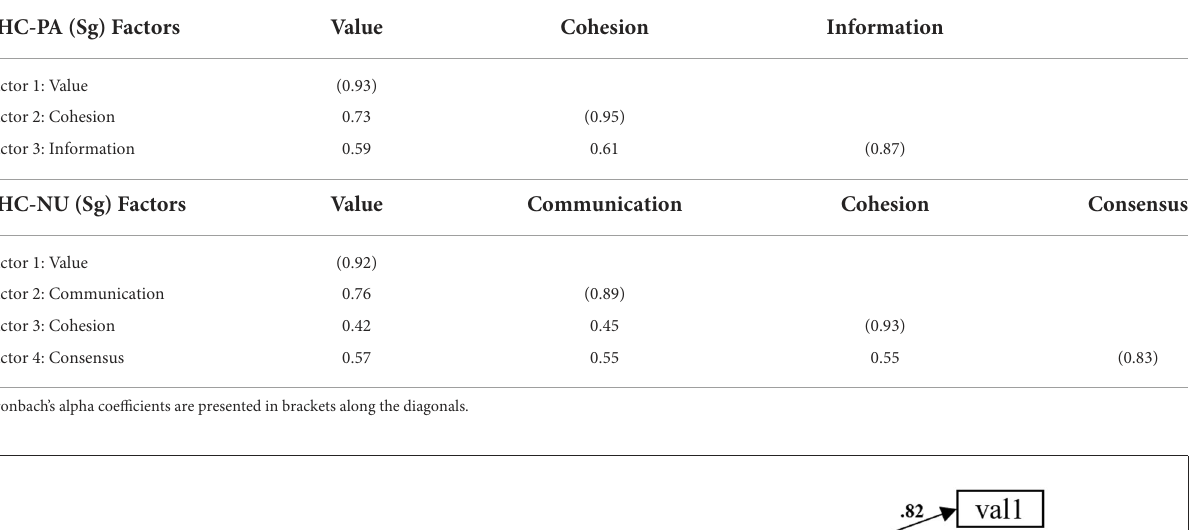
factors were smaller than their reliability coefficients (Table 3), indicating unique variance measured by the factors (42), their internal consistency was high (0.93 and 0.83 for cohesion and consensus respectively; Table 3), and their inclusion allowed us to follow the original interpretation of the FHC model more